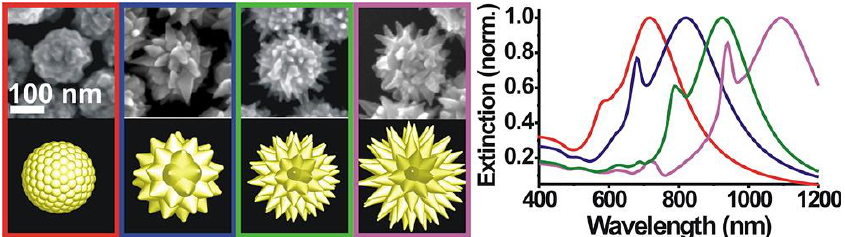
Figure 18. Spiky gold nanoshells: TEM images, morphologies and the corresponding extinction spectra. Reprinted with permission from Reference [19]. Copyright (2013) American Chemical Society.